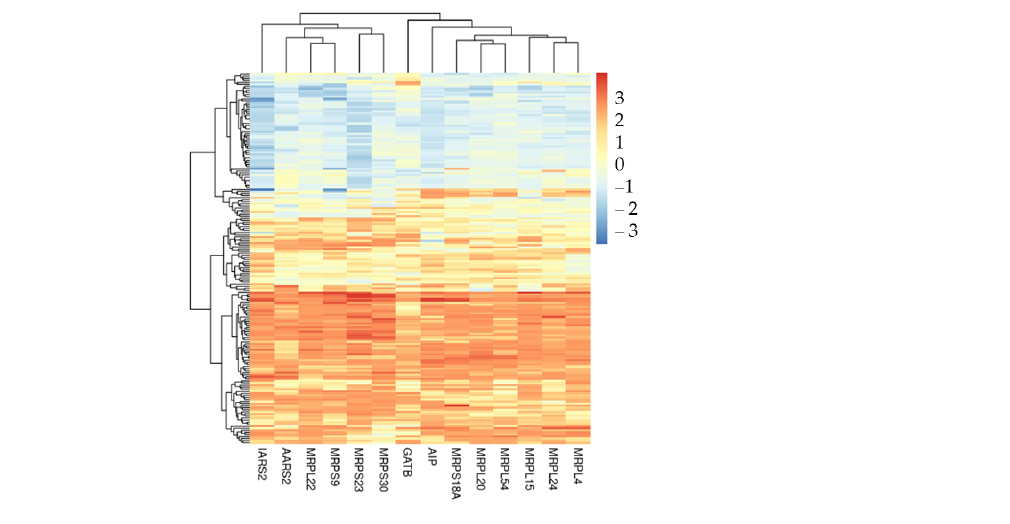
Figure 3. Heatmap of differentially expressed features in mitochondrial translation ontology. For each DEG inside this biological process, we plotted its expression level among the 180 individuals of the cohort.